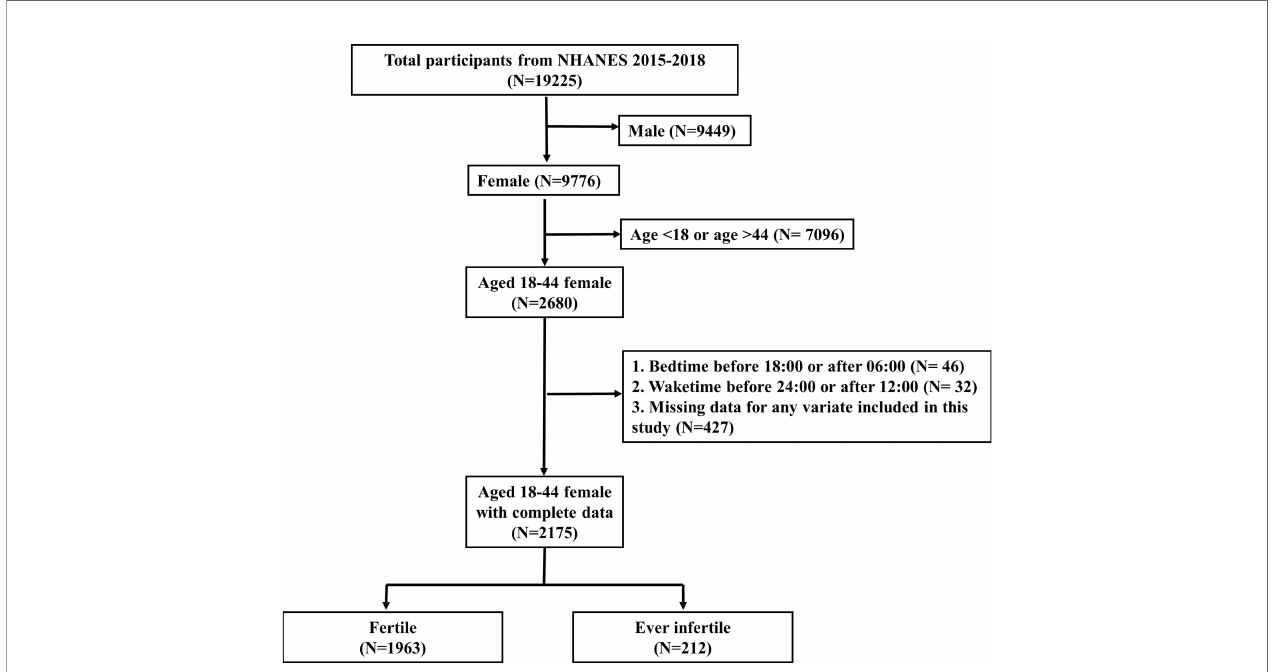
FIGURE 1 | Flowchart of participant selection. NHANES, National Health and Nutrition Examination